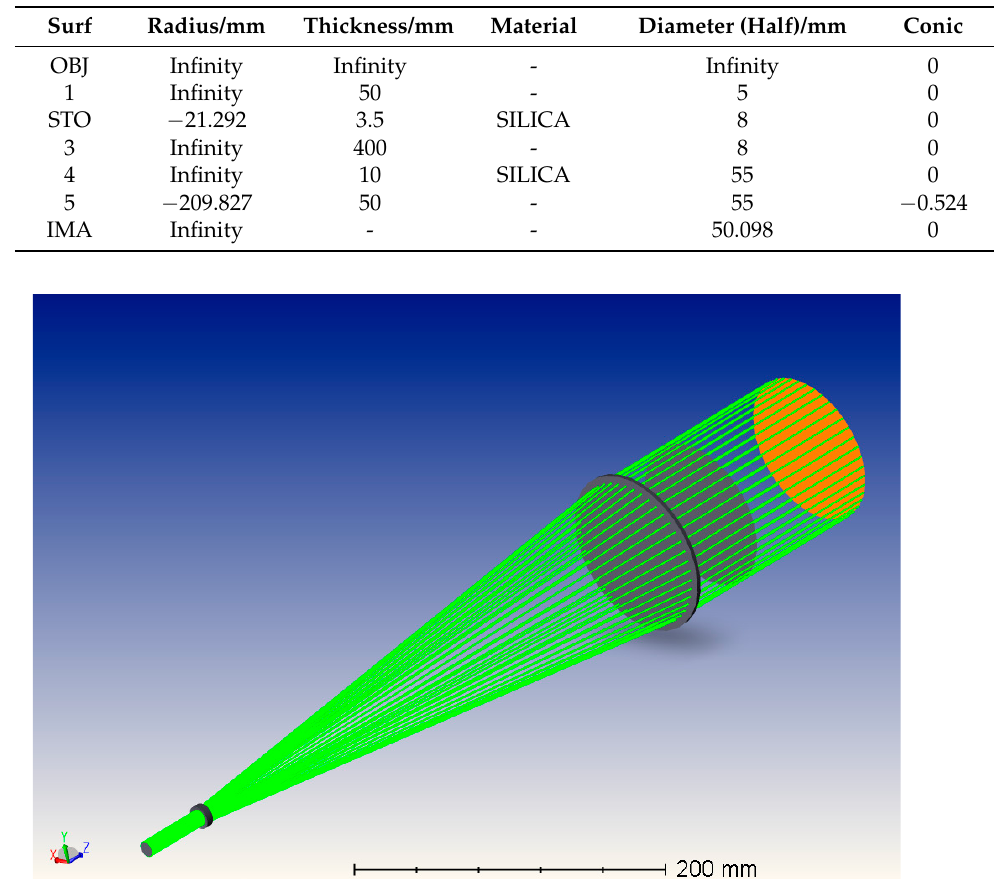
Table 4. The optimized beam expander structural parameters.